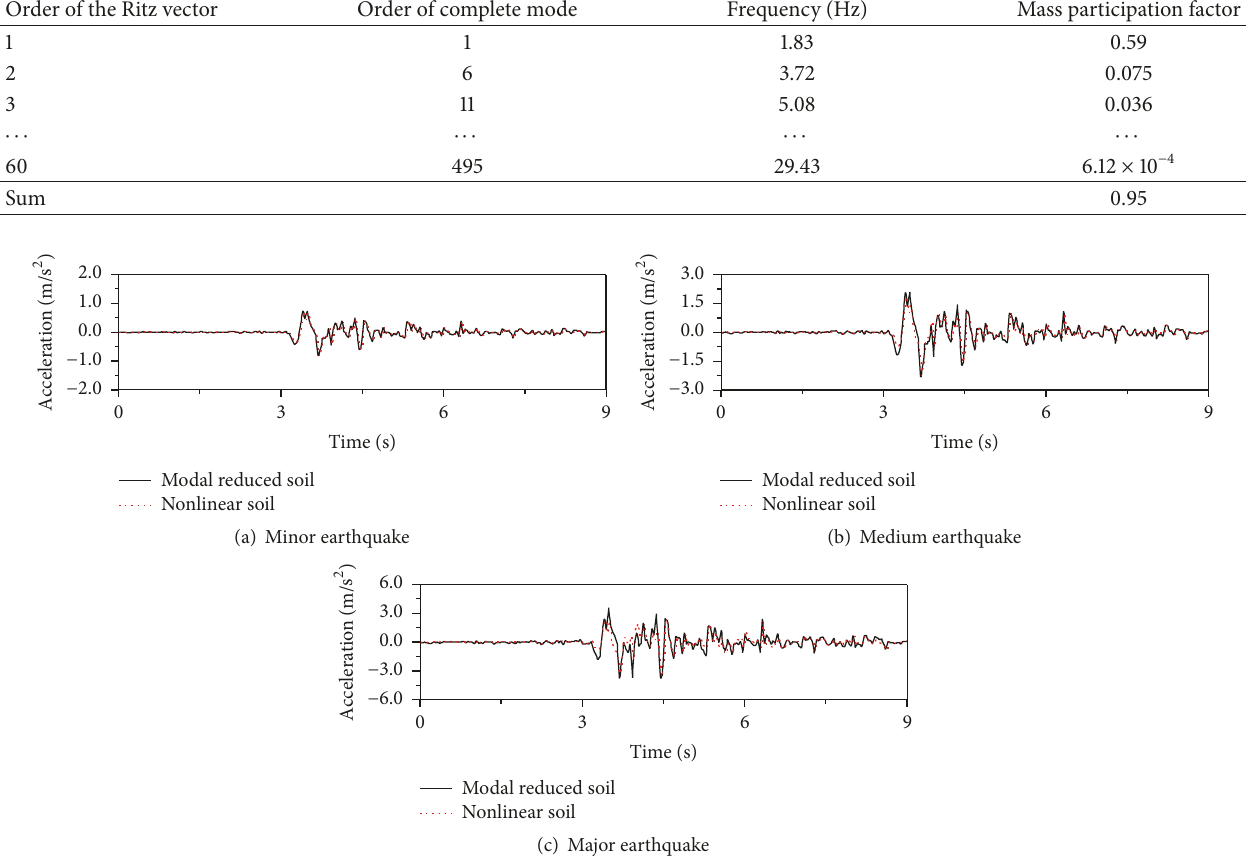
Figure 6: Comparison of the foundation center’s acceleration responses produced by the two computational models.